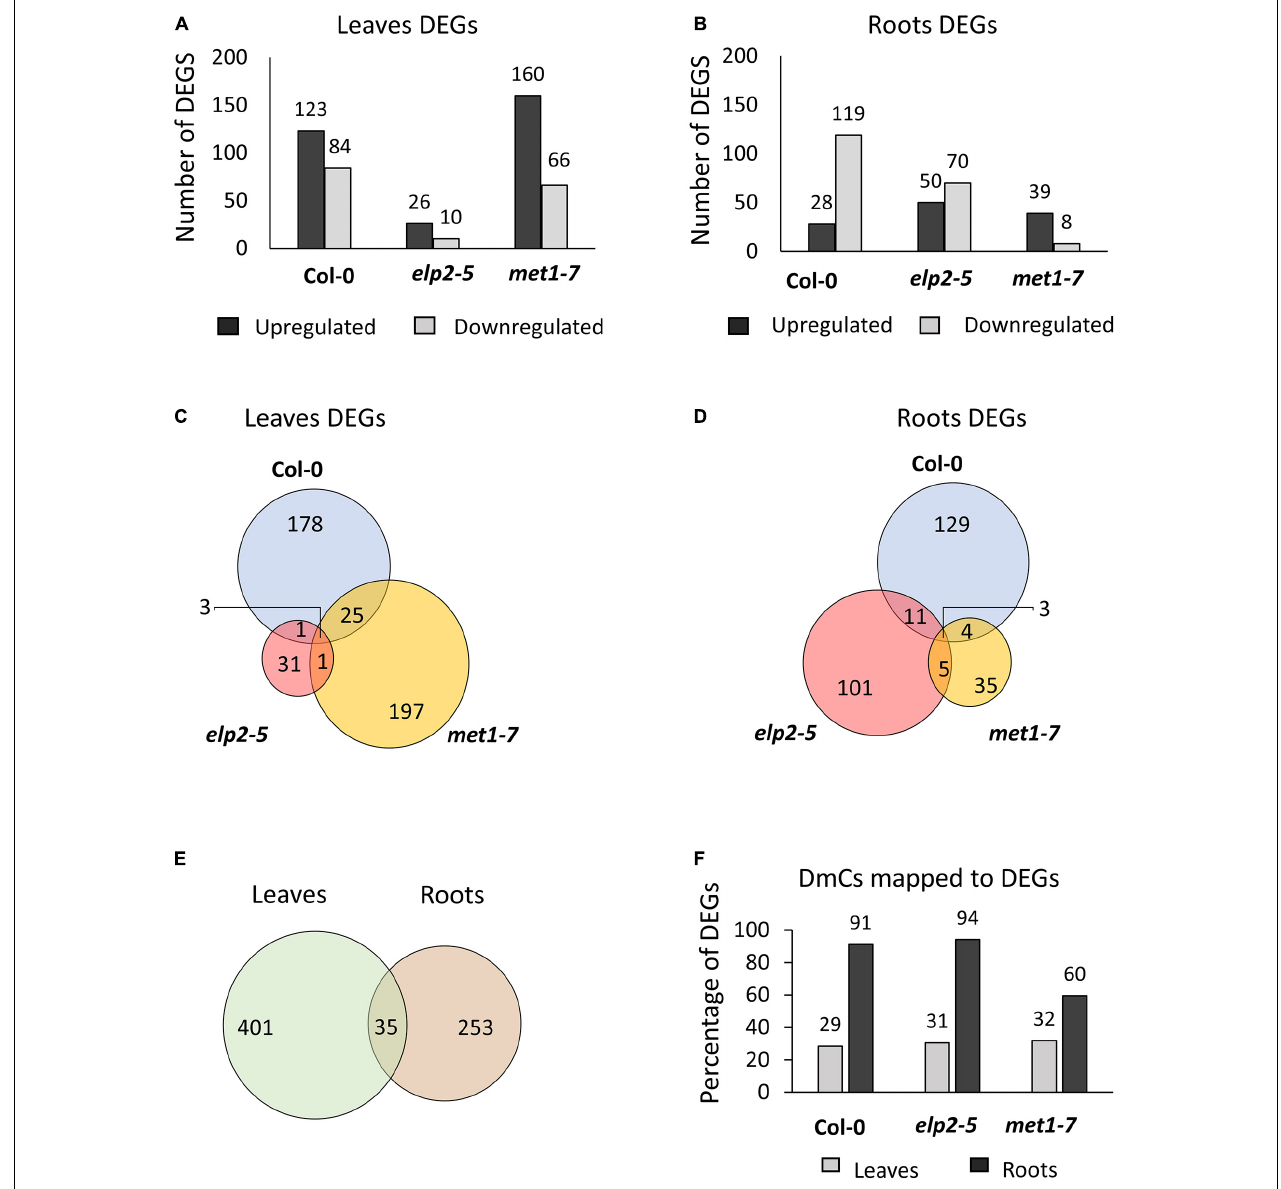
FIGURE 7 | Analysis of differential gene expression in response to spaceflight and the relationship between DmCs. Bar graph showing the number of differentially expressed genes (DEGs) in response to spaceflight (spaceflight compared to ground control) of each genotype in (A) leaves or (B) roots. Black bars indicate the number of up-regulated genes whereas gray bars indicate the number of down-regulated genes. Venn diagrams showing the DEGs that overlap between each genotype in response to spaceflight in both (C) leaves and (D) roots. (E) Venn diagram of the DEGs that overlap in leaves and roots. (F) Bar graph showing the percentage of DmCs that mapped to DEGs in leaves (gray bar) and in roots (black